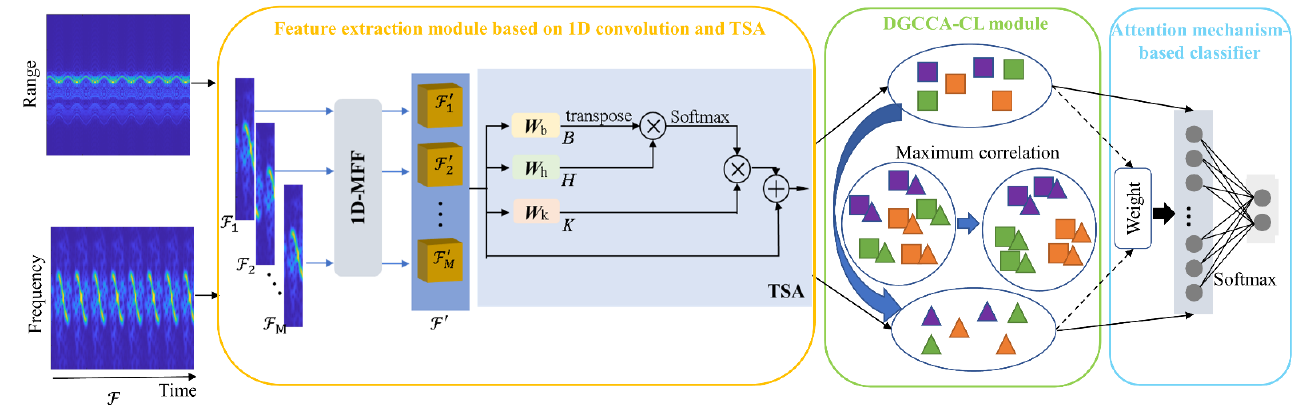
Figure 1. The overall network structure of the proposed method ( ⊗ and ⊕ represent matrix multiplication and element-wise addition, respectively).